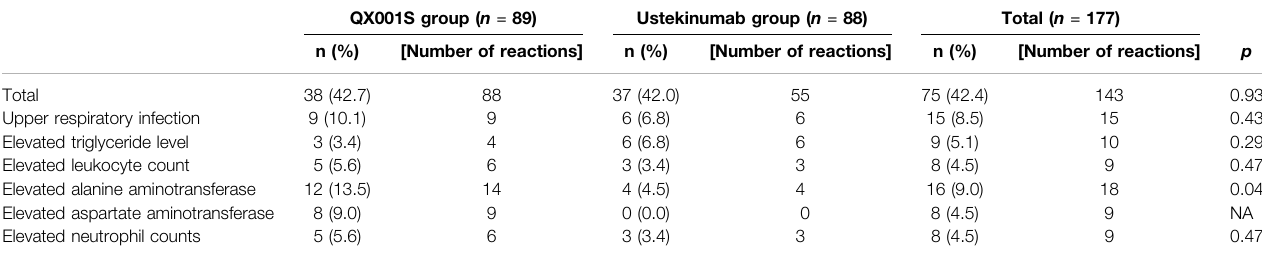
TABLE 4 | Adverse reactions (number of reactions, number [%] of participants, more than